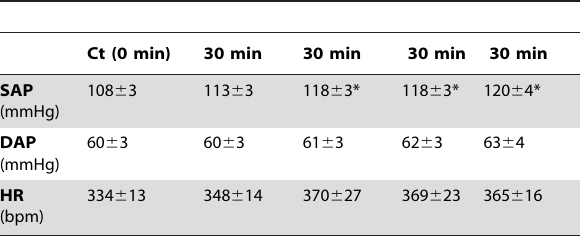
Table 1. Hemodynamic parameters upon acute lead